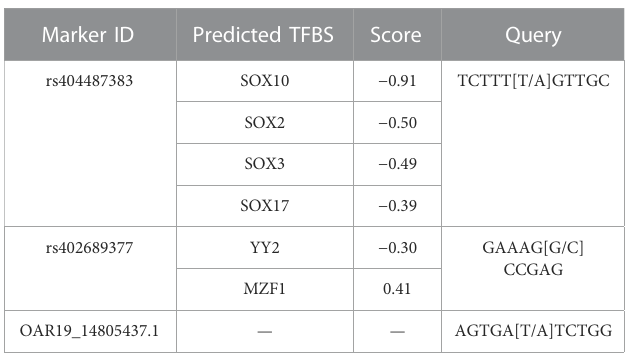
TABLE 5 Predicted TFBS for SNPs located within genes. Query sequences were analyzed with the major allele as “ wild type ” and the minor allele as “ variant ” sequence. The score depicts the difference of wild type versus variant predictions.